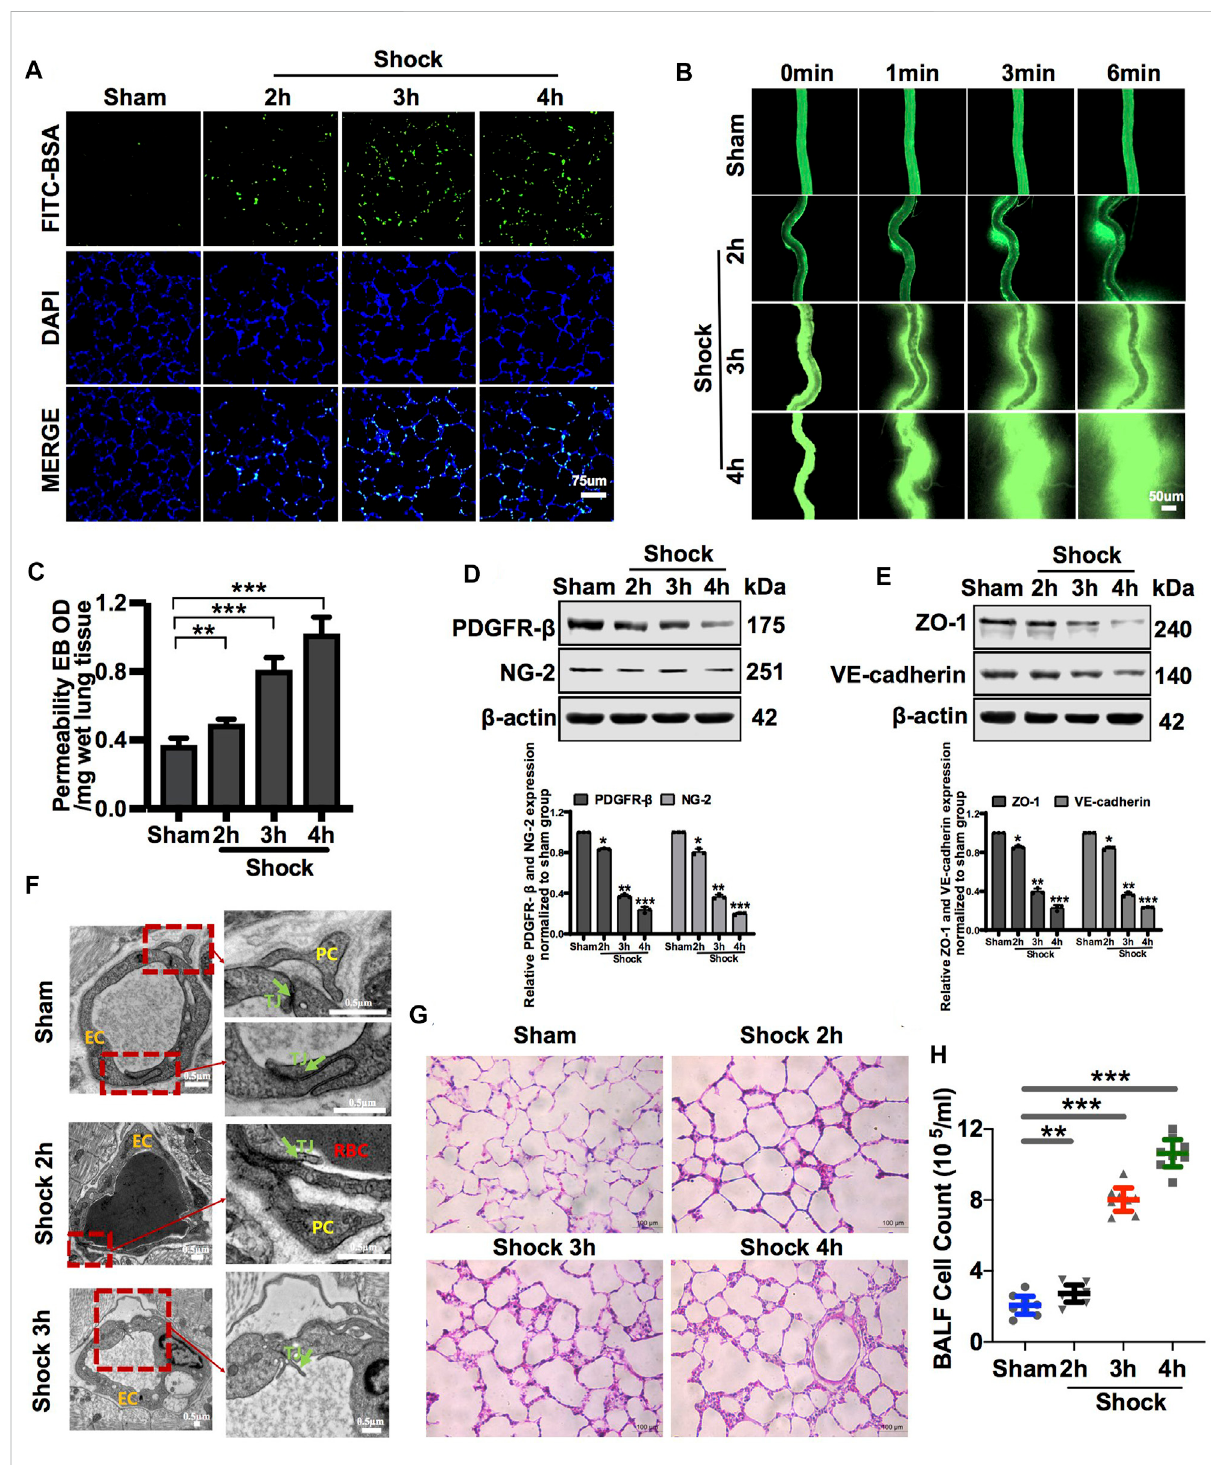
FIGURE 1 Vascular permeability presented a negative correlation with the amount of PC in vessels during hemorrhagic shock. (A) Pulmonary vascular permeability determined by FITC-BSA ( n = 8). (B) Mesenteric microvascular permeability determined by FITC-BSA ( n = 8 mesenteric microvessels fromeightrats). (C) PulmonaryvascularpermeabilitydeterminedbyEBleakageinlungtissue( n =8). (D) ProteinexpressionofPDGFR- β andNG-2in pulmonary veins after hemorrhagic shock determined by WB ( n = 12 pulmonary veins from three rats). (E) Protein expression of ZO-1 and VE- cadherin inpulmonaryveins determined byWB( n =12 pulmonary veinsfrom threerats). (F) StructureofPCsandthetightjunction structureofVECs observedbyTEM( n =32pulmonaryveinsfromeightrats). (G) In fi ltrationofin fl ammatorycellsinthealveolarspacewasobservedbyHEstaining( n = 8). (H) Cell counts in bronchoalveolar lavage fl uid (BALF) after hemorrhagic shock ( n = 8). * p < 0.05, ** p < 0.01, and *** p < 0.001 compared with the sham group (one-way ANOVA). RBC, red blood cell; L, lumen; TJ, tight